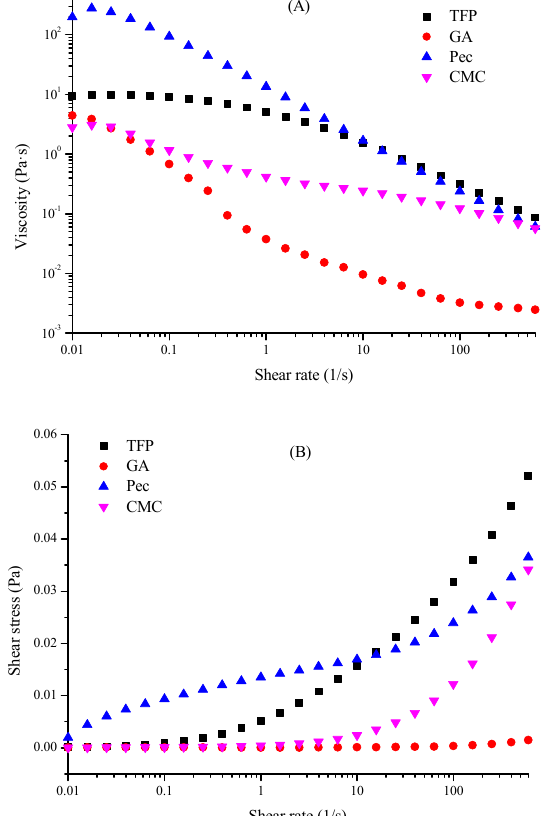
Figure 6. Rheological properties of different emulsions ( A ) Viscosity-shear rate relationship; ( B ) Shear stress-shear rate relationship.